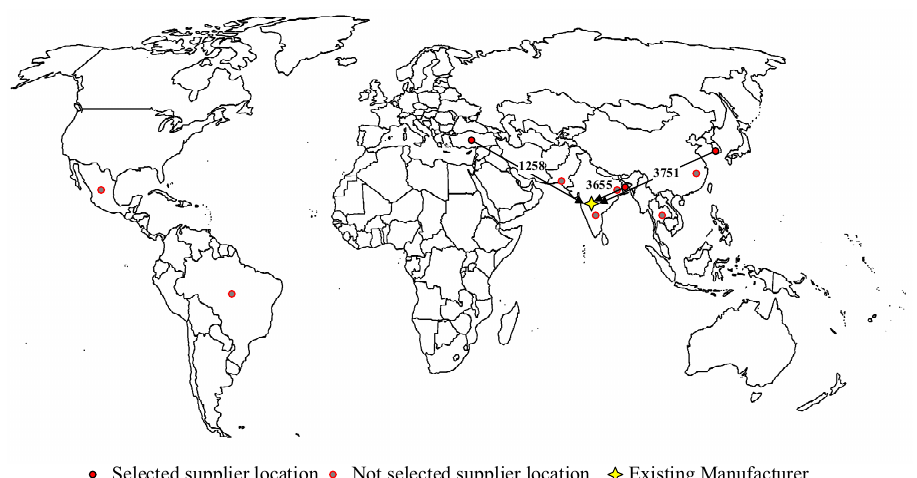
Figure 3 . Final decision based on decision makers preferences. Figure 3. Final decision based on decision makers